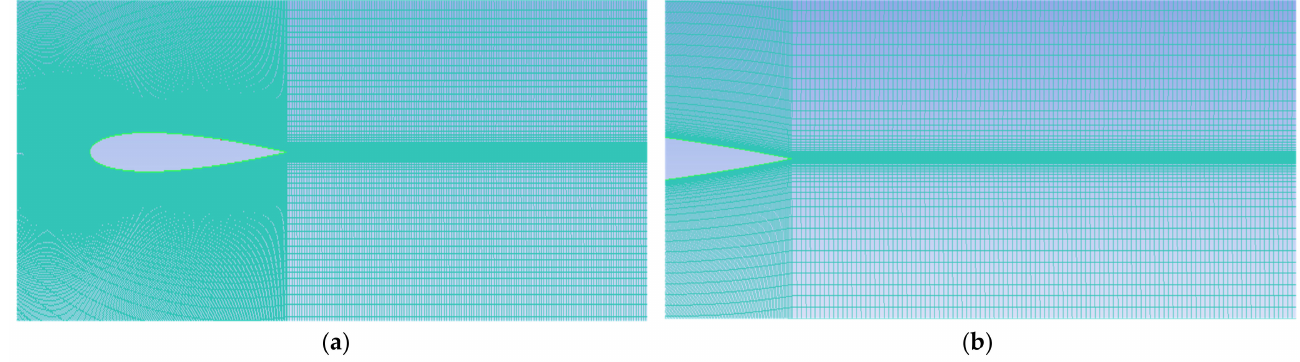
Figure 3. ( a ) Close view of meshes near the WALL region; ( b ) Close view of meshes near the sharp trailing edge.